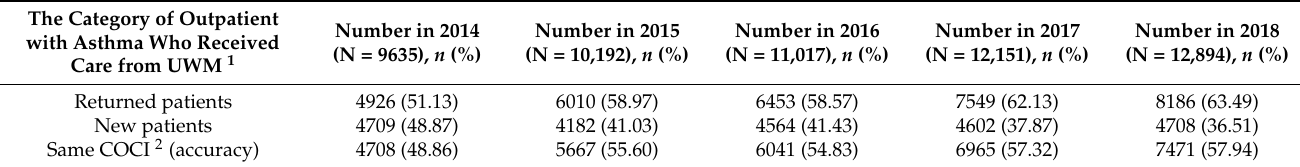
Table 1. The distributions of the patients and the data instances between 2014 to 2018.